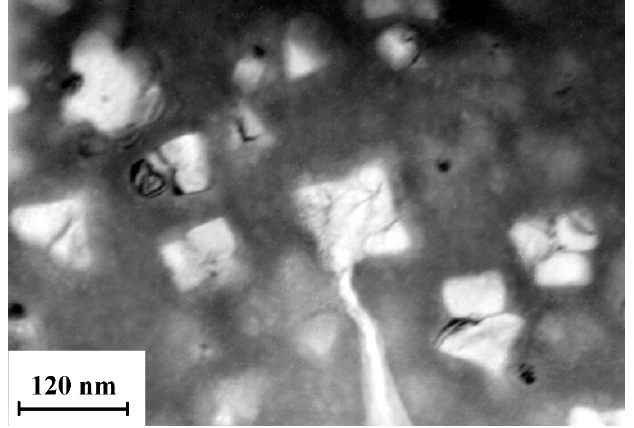
Figure 12. Bright-field image (TEM) of crack arrest on nanocrystalline particle in the Fe 58 Ni 25 B 17 AA annealed at T an = 658 K.